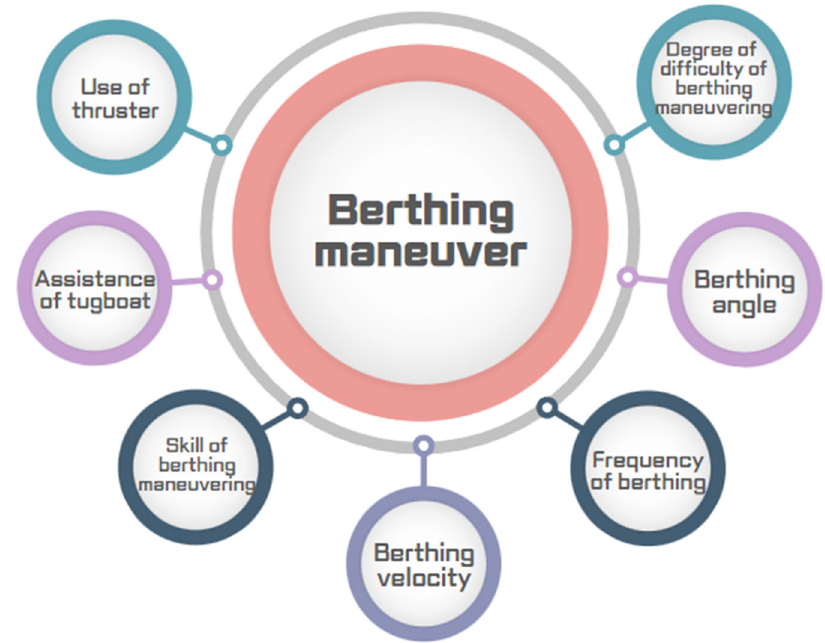
Figure 2. Partial items to be considered in fender design.